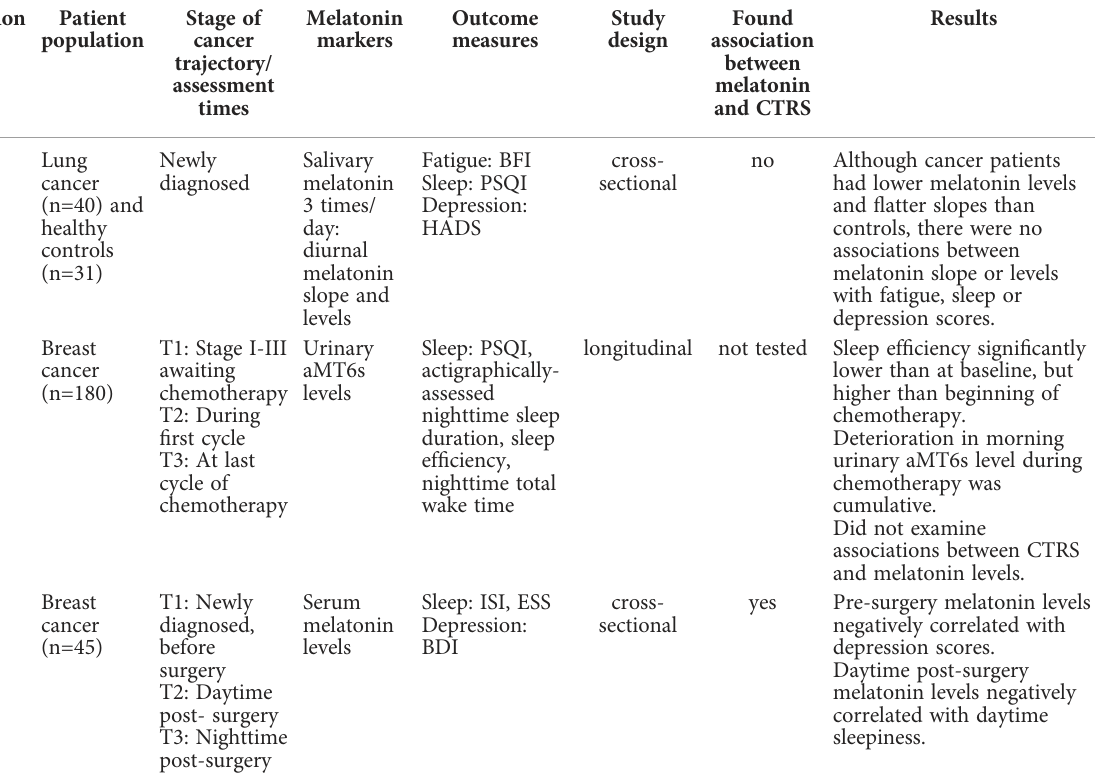
TABLE 1 Summary of studies that examined melatonin and cancer- and treatment-related symptoms